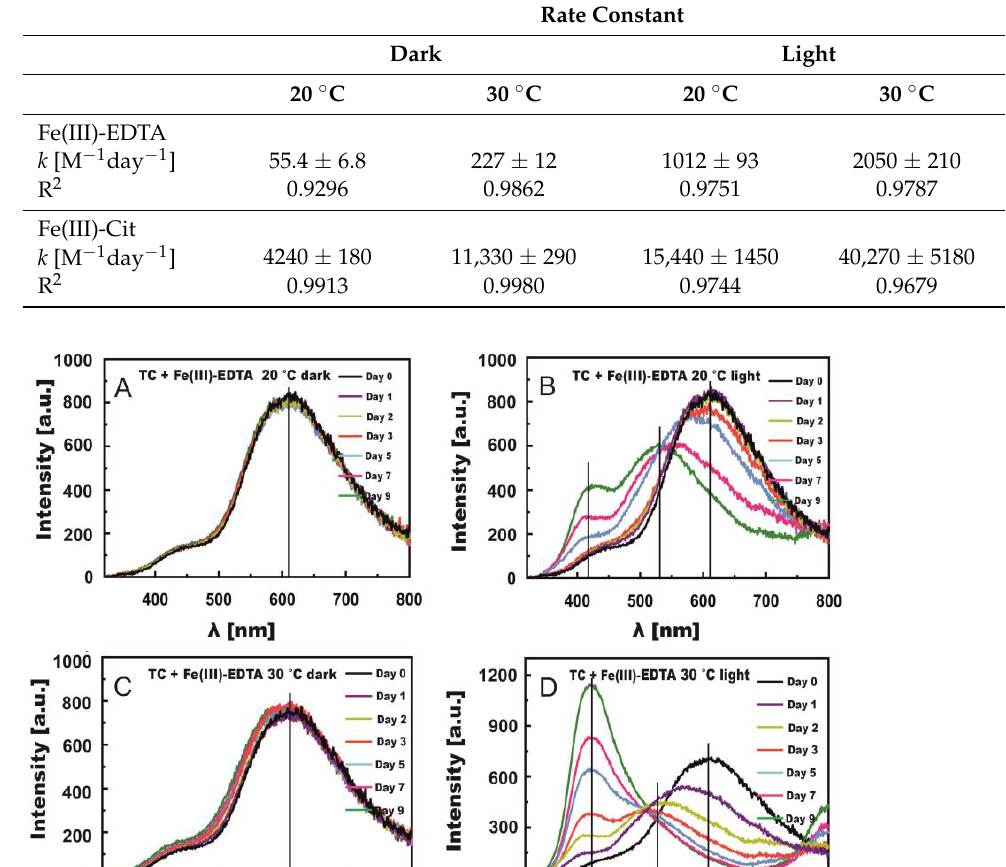
Table 3. The reaction rate constants for TC degradation under different experimental conditions (light or darkness, 20 ◦ C and 30 ◦ C temperature) in the presence of Fe(III)-EDTA or Fe(III)-Cit.